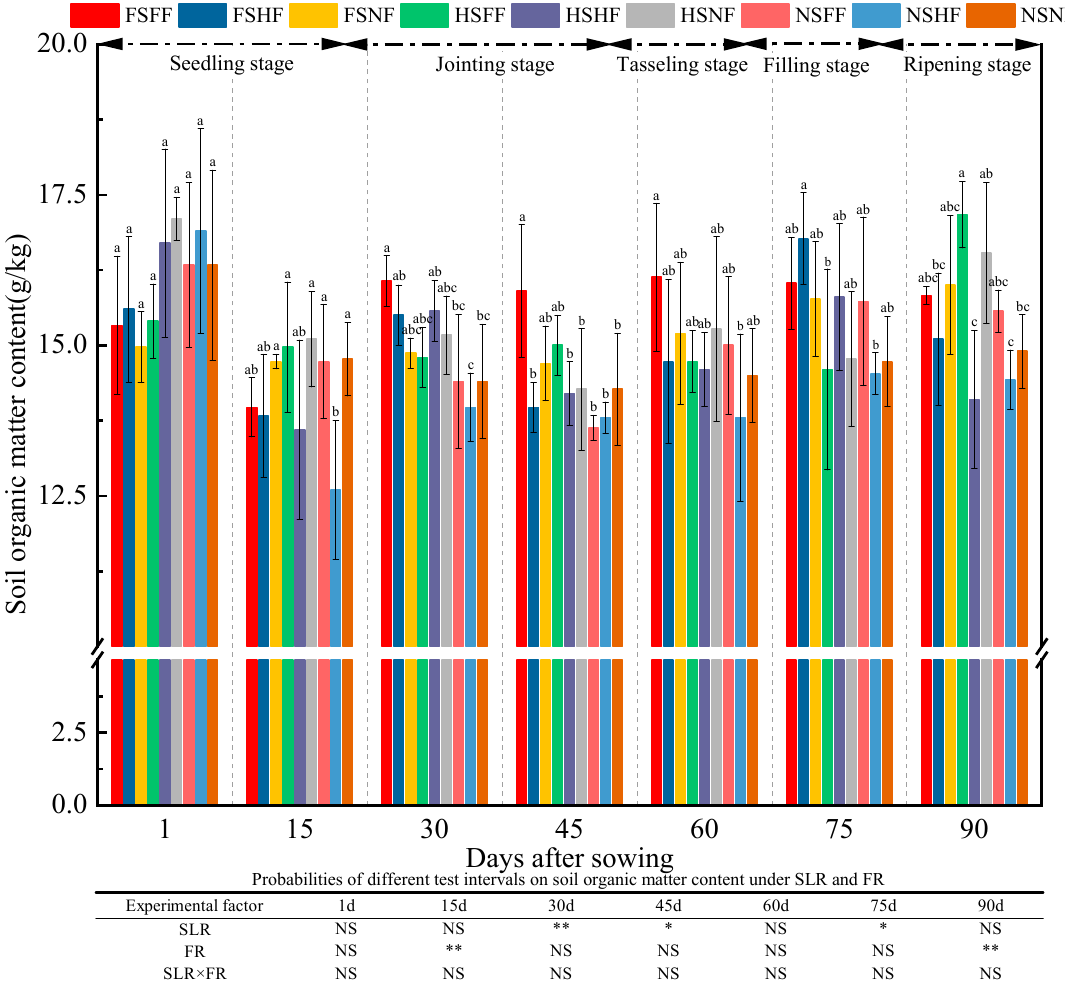
Figure 13. Effects of SLR and FR on the SOM content. Note: Bars represent means ± standard deviation ( n = 3) with different letters indicating significant differences based on LSD ( p ≤ 0.05). SLR, sugarcane leaf return; FR, fertilizer reduction.